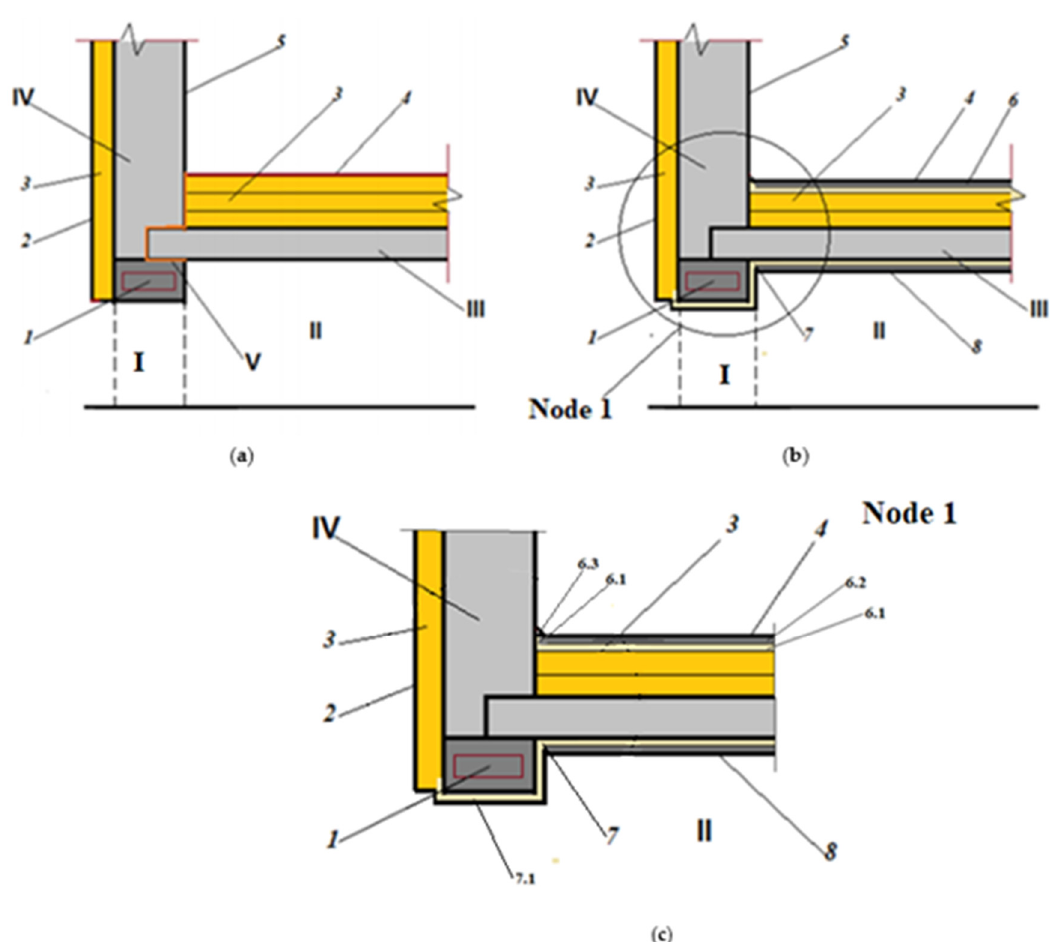
Figure 10. Floor plan of a residential building (Section 2—wall between columns and details of node 1): I—column; II—ventilated space; III—overlap above ventilated space;